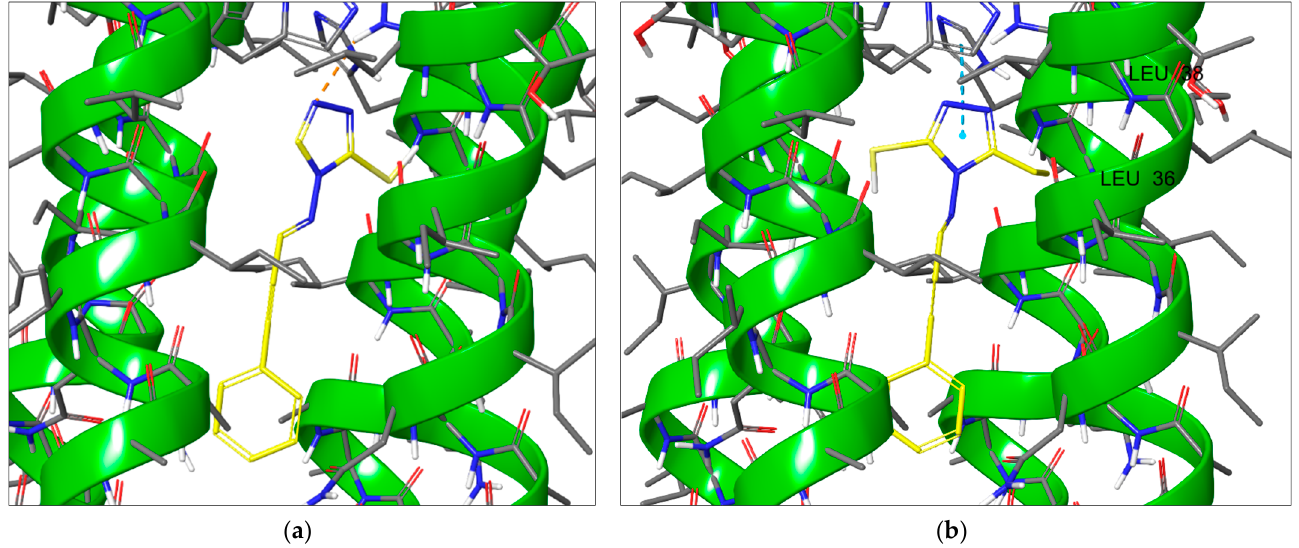
Figure 9. Binding poses of ( a ) 1a and ( b ) 1c in M2 channel active cavity; orange dashed line: strained protein-ligand contact, blue dashed line: pi-stacking interaction.